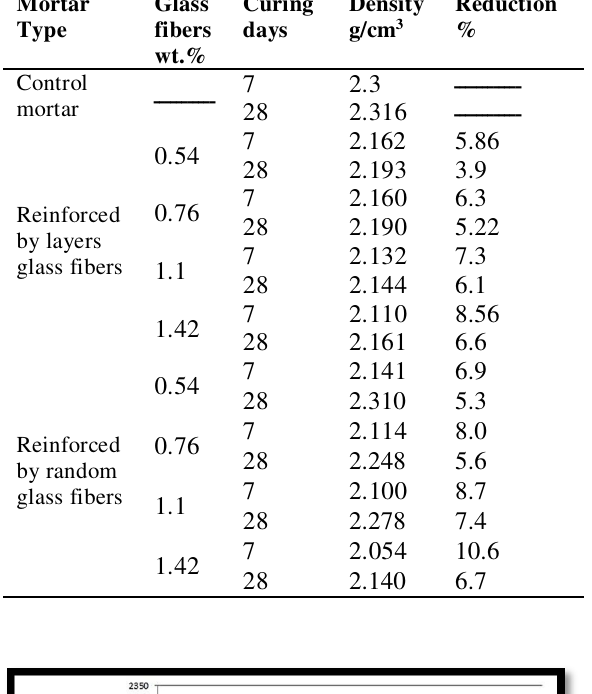
Results of density testing for glass fibers reinforced mortar without SBR.